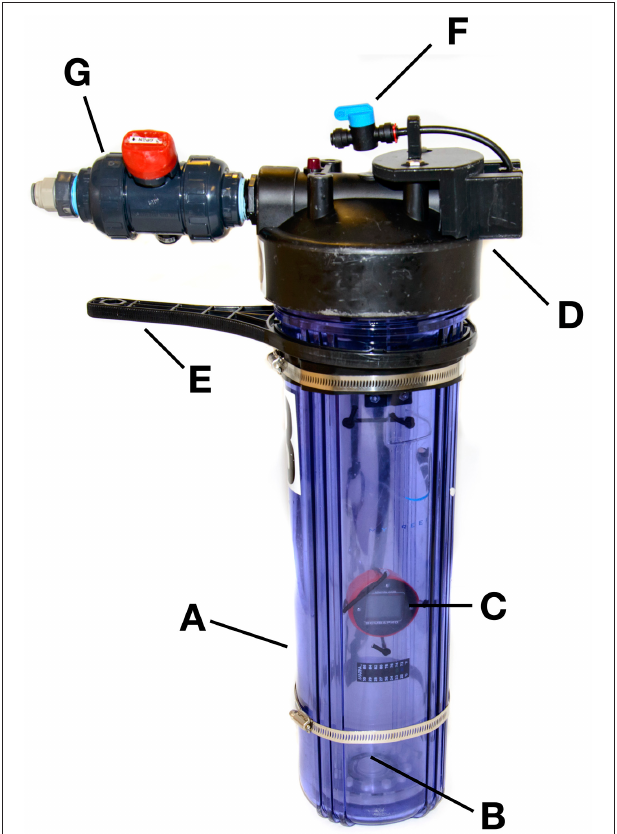
FIGURE 1 | The portable, submersible hyperbaric chamber (SubCAS) described in the text, showing: (A) hyperbaric chamber, (B) inner collecting